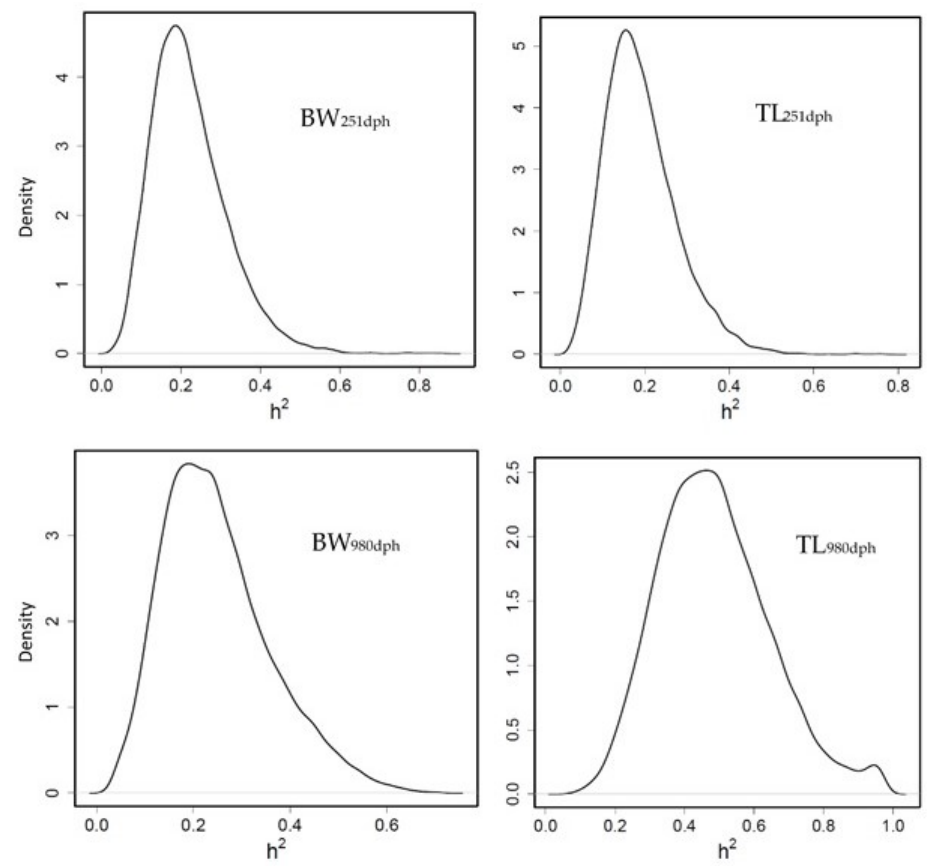
Figure 1 . Posterior marginal distribution of heritabilities of body weight (BW) and total length (TL) gilthead seabream. h2 = heritability (n = 399).